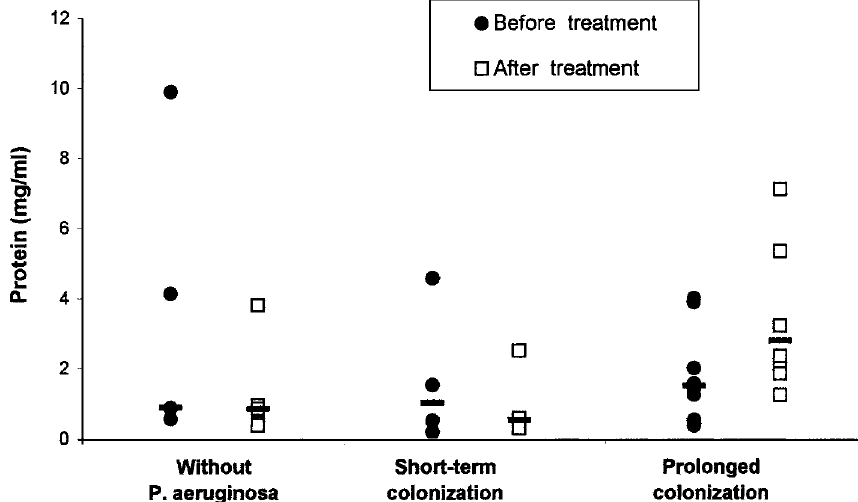
FIG. 5. Protein concentrations in the sputum samples from CF patients during exacerbation treatment. Determination of protein amount was performed by Bradford’s method. Data reported were compared by unpaired, two-tailed Student’s t -test. There were no statistically significant differences between patient groups. Symbols as in Fig.